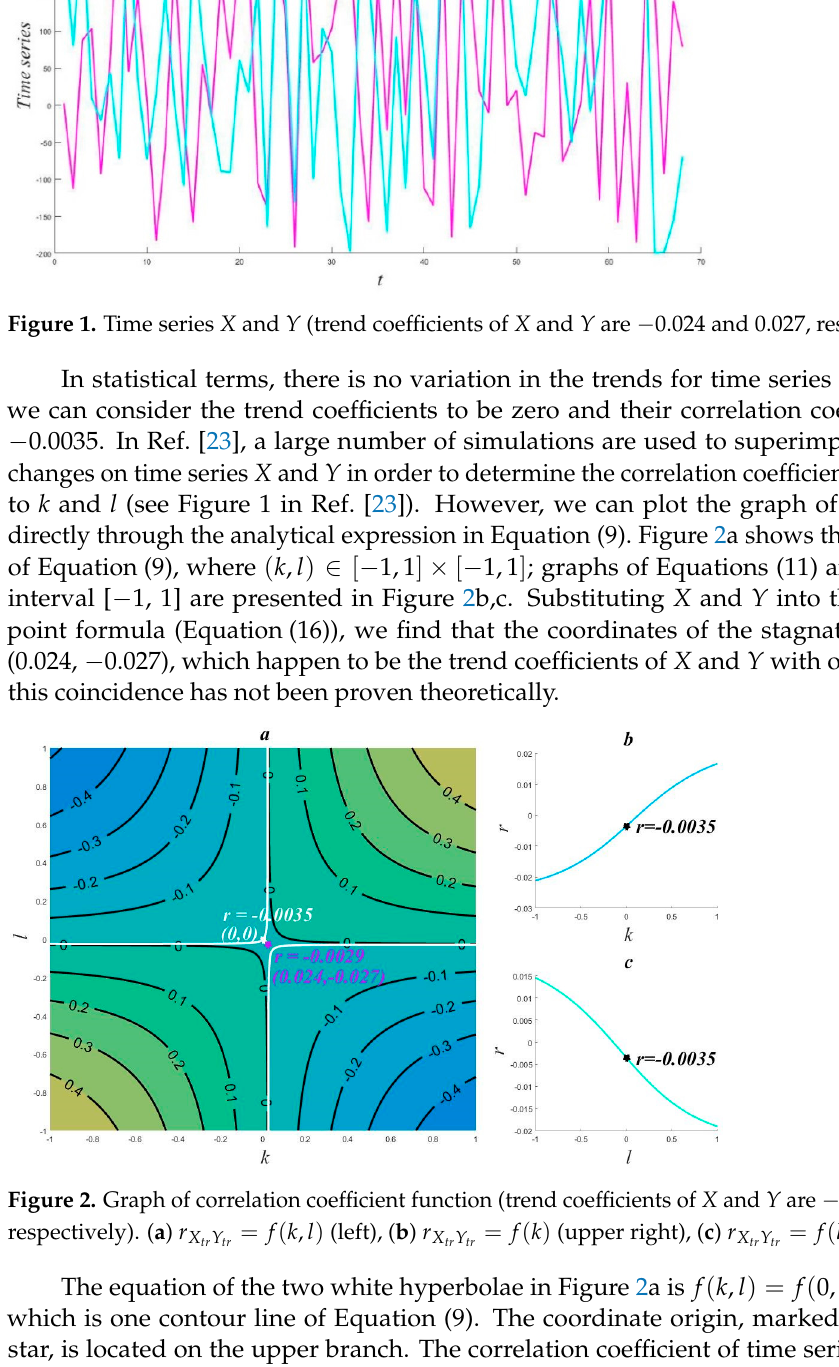
Figure 1. Time series X and Y (trend coefficients of X and Y are − 0.024 and 0.027, respectively).